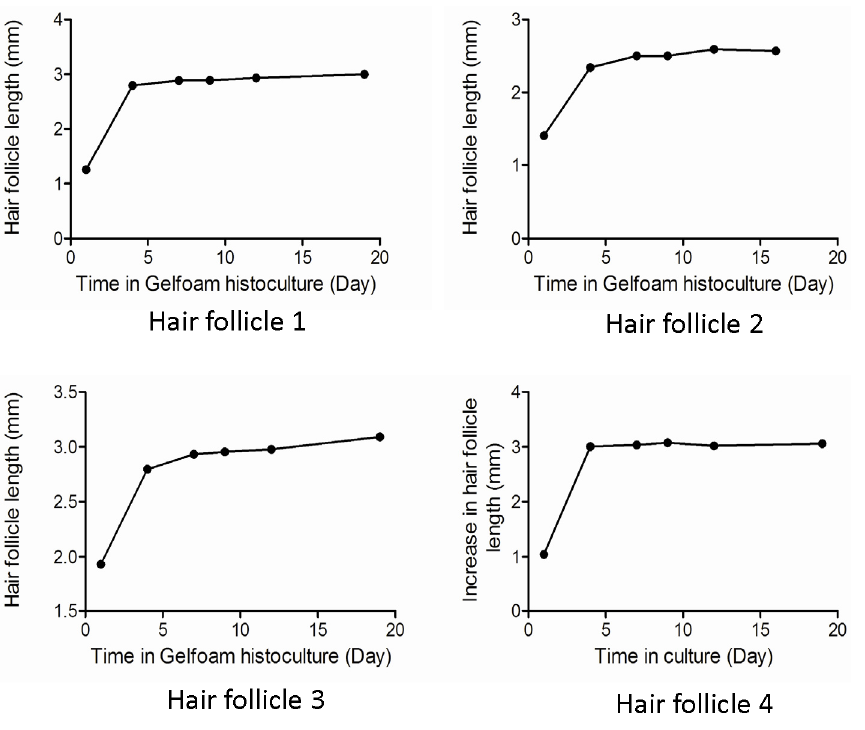
Fig 2. Graphs quantifying the increase of shaft length over time in individual follicles during Gelfoam 1 histoculture.